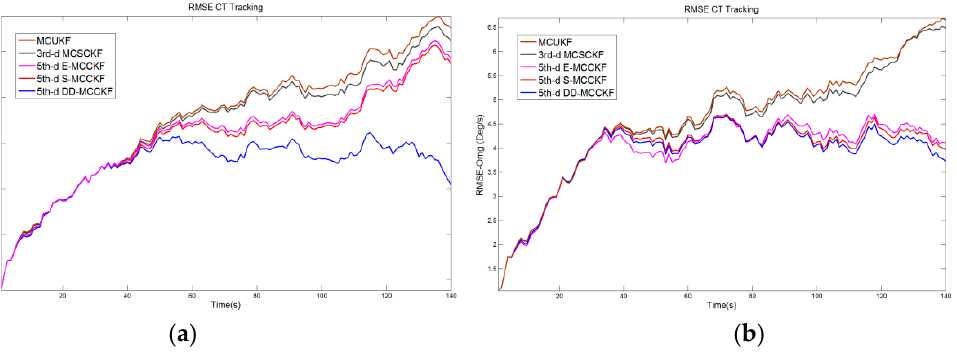
Figure 9. Velocity RMSEs of robust target-tracking algorithms under non-Gaussian noise conditions (( a ) is the result under Equation (65) and ( b ) is the result under Equation (66)).